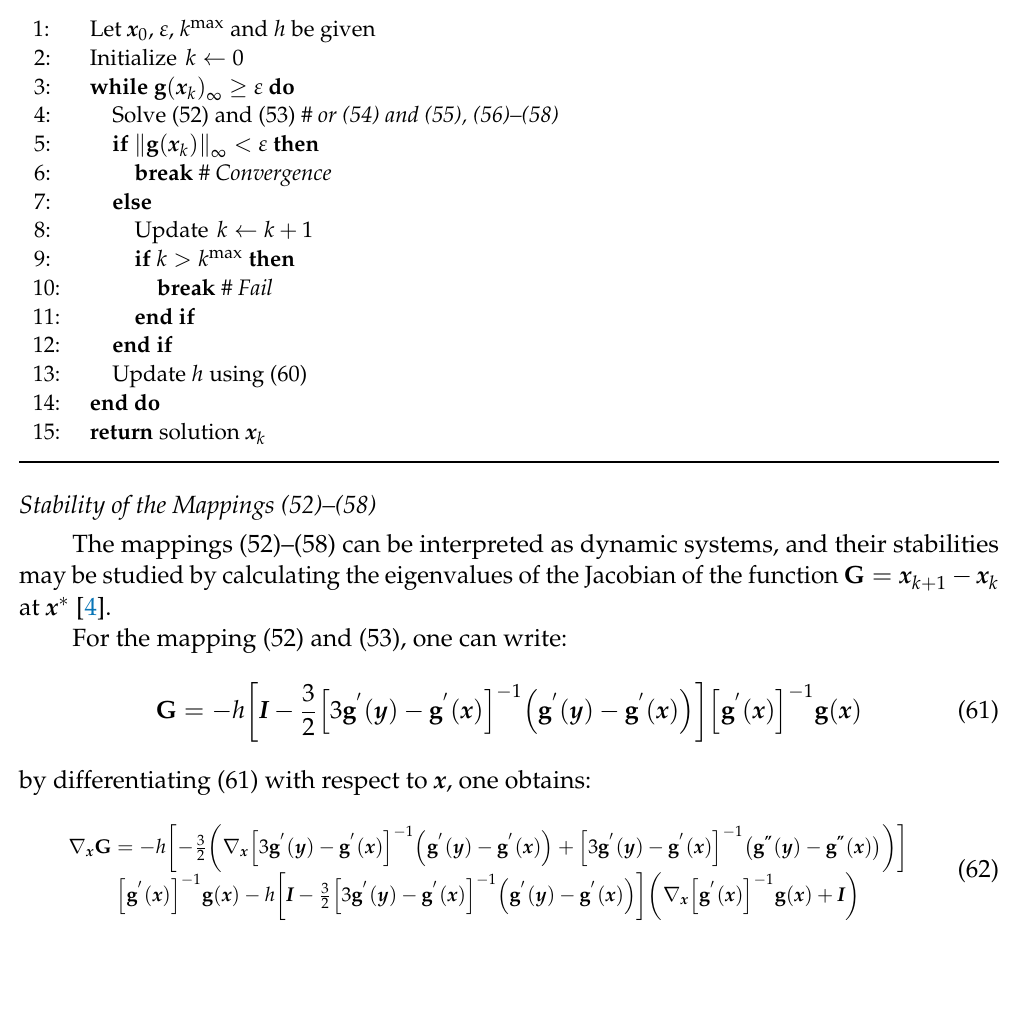
Algorithm 1 main steps of PFC using